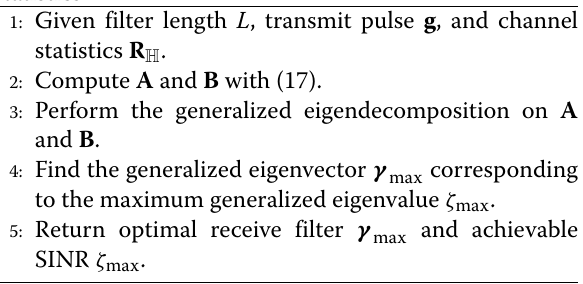
Algorithm 2 Optimal receive filter design with channel